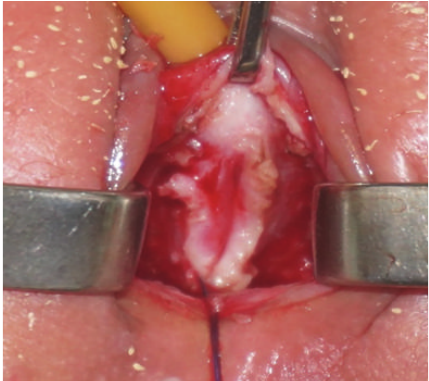
Figure 6: Dissection between urethra and vagina and beginning of urethral